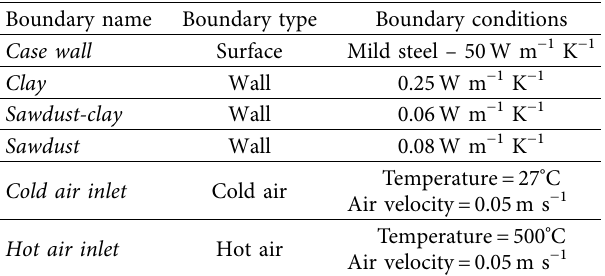
Figure 5: (a) Computational fluid dynamics, (b) geometry, (c) surface mesh, and (d) BuoyantSimpleFoam for the fire stove. Table 2: Stove model boundary